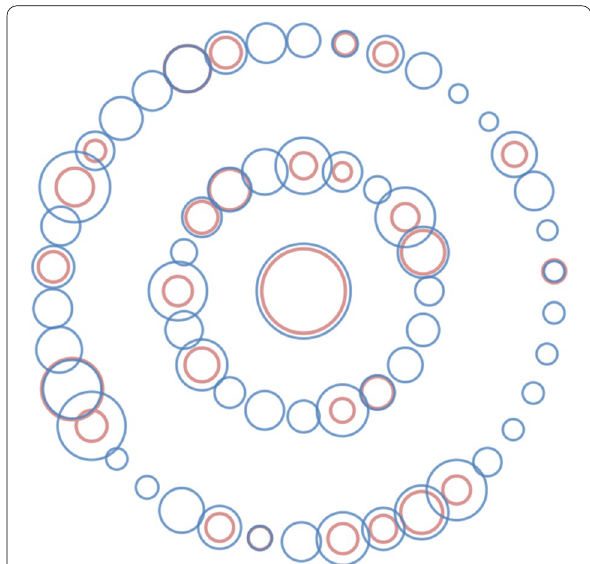
Fig. 1 Bubble chart based on the viral load detected by the traditional qPCR and the qPCR assay followed by M1 bead enrichment. The bubble size is the square root of viral load, the number of blue bubbles is the number of positive samples after enrichment, the number of pink bubbles is the number of positive samples before enrichment. The common center of two bubbles shared by the same